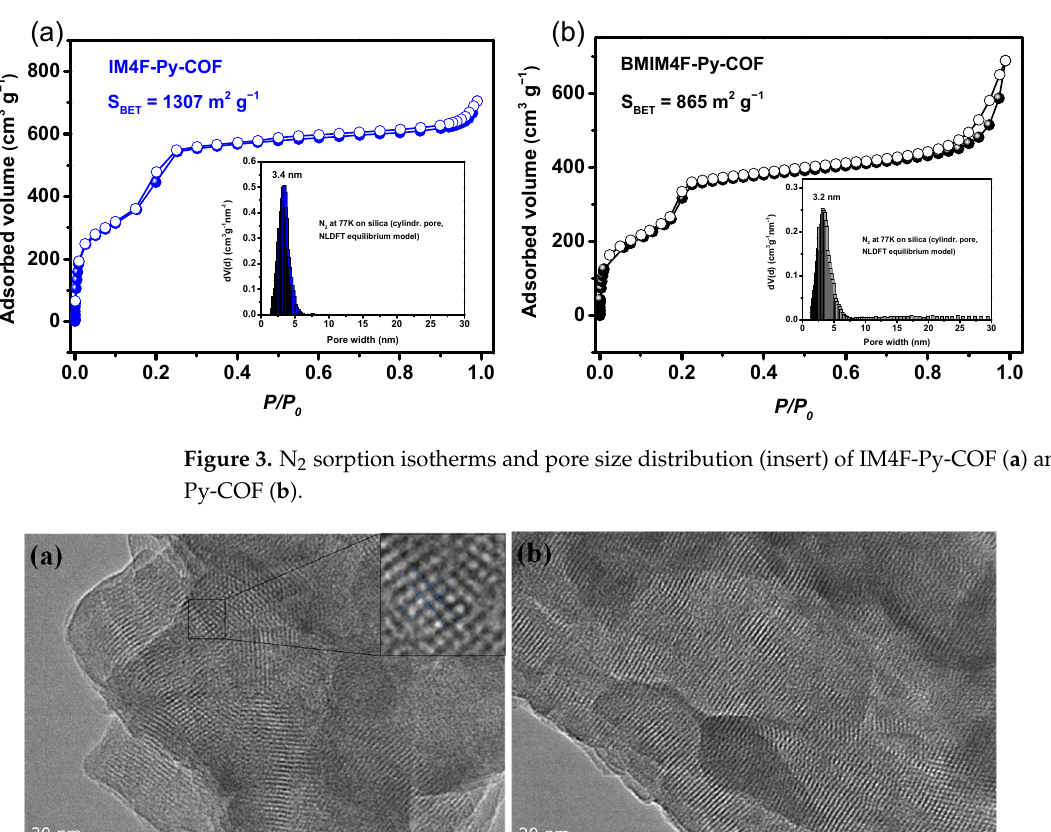
Figure 3. N 2 sorption isotherms and pore size distribution (insert) of IM4F-Py-COF ( a ) and BMIM4F-Py-COF ( b ).